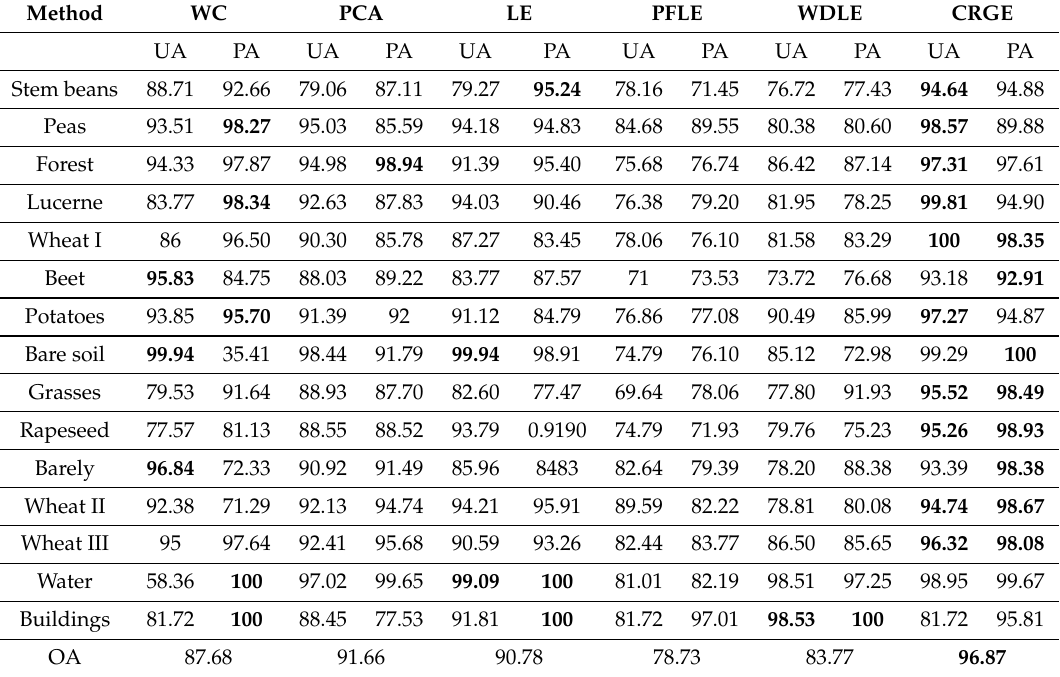
Table 2. Classification accuracies of six methods on the Flevoland data